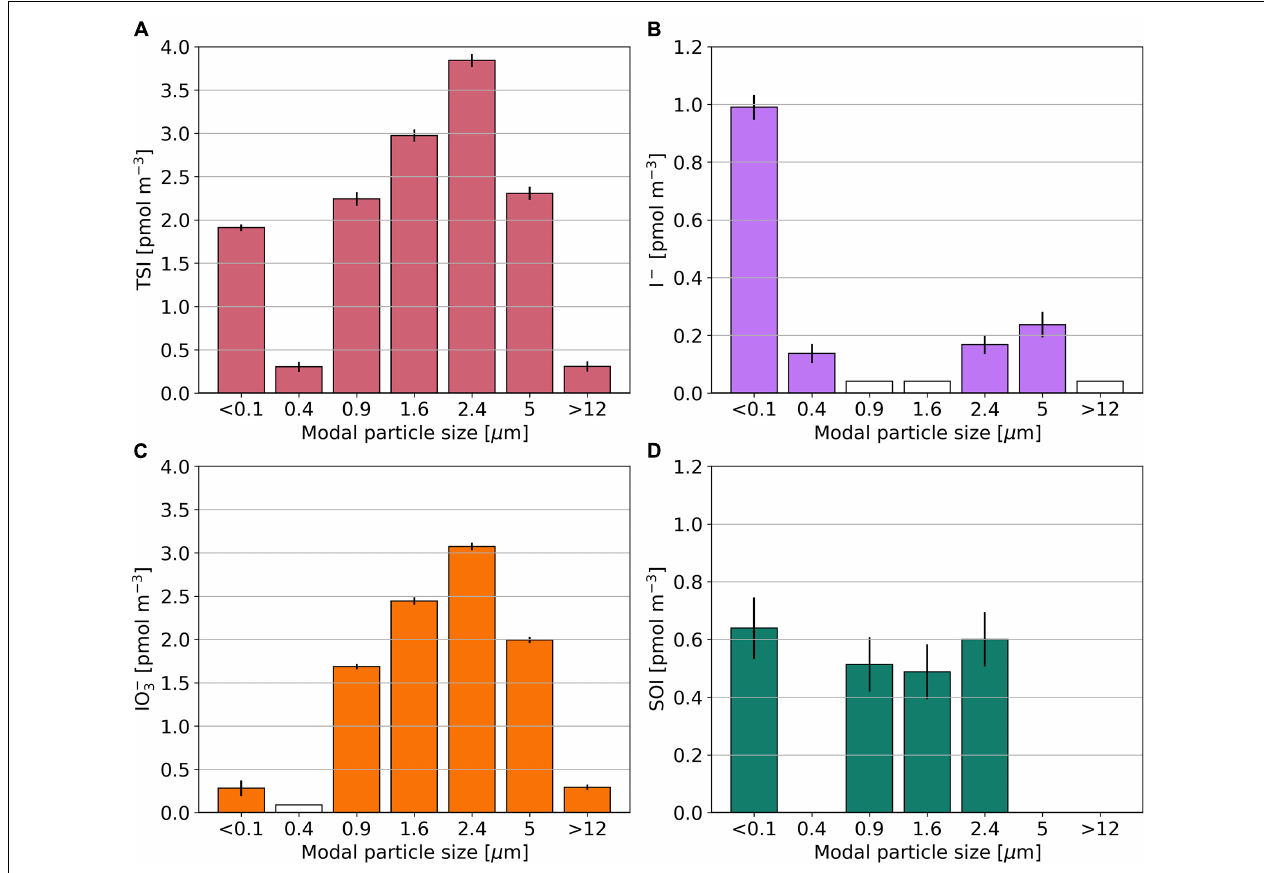
FIGURE 6 | Bar plots showing the TSI (A) , I - (B) , IO 3 - (C) , and SOI (D) concentrations for the multi size segregated aerosol sample O10, collected during the OASIS expedition. Empty bars indicate concentrations below the detection limit. SOI concentrations for which the error is larger than the parameter itself are